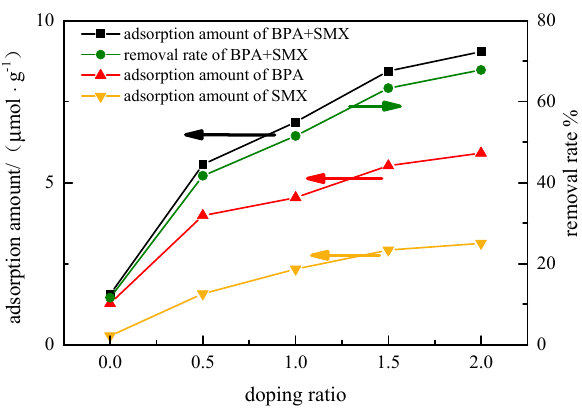
Figure 2. E ff ect of doping ratio of modified attapulgite on adsorption Figure 2. Effect of doping ratio of modified attapulgite on adsorption performance.